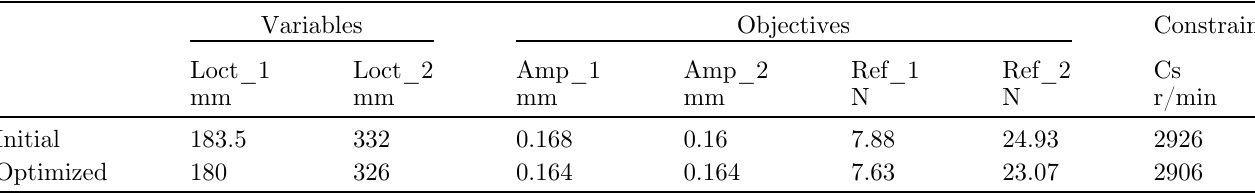
Table 3. The rotor optimization design result considering the